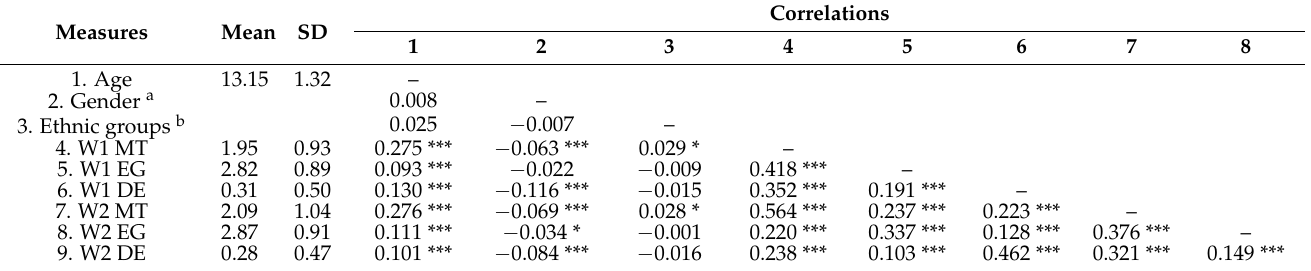
Table 3. Descriptive and correlational analyses (W1: N = 5690; W2: N = 4981).